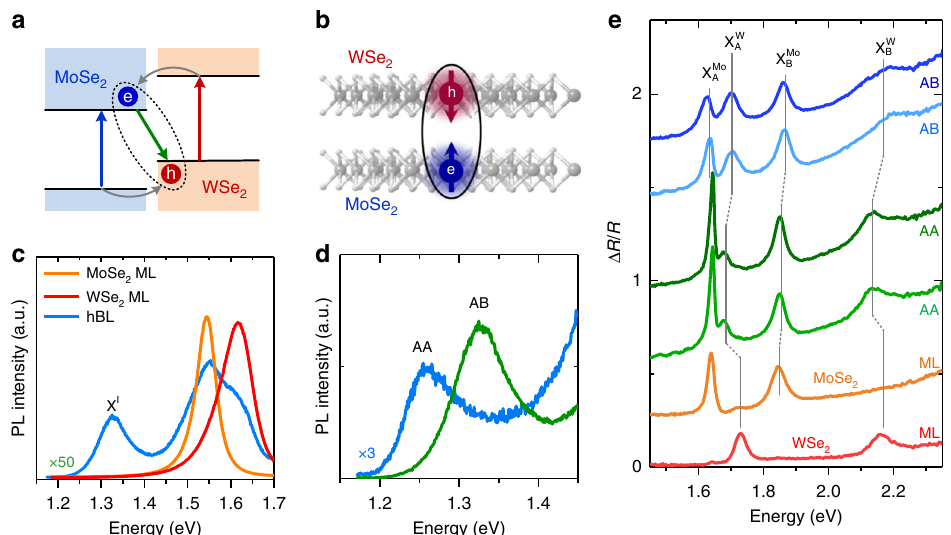
Fig. 2 Interlayer excitons in WSe 2 /MoSe 2 hBLs with AA and AB stacking. a The type-II band alignment of WSe 2 /MoSe 2 hBLs. b Schematics of interlayer excitons with electrons (e) and holes (h) located in the MoSe 2 and WSe 2 layers, respectively. c PL spectra for monolayer WSe 2 , MoSe 2 , and the WSe 2 / MoSe 2 hBL with AB stacking. The interlayer exciton X I is observed at 1.33 eV. d A comparison of X I peaks in hBLs with AA and AB stacking. The PL spectra shown in c and d were measured at room temperature ( T = 300 K). e Differential re fl ectance spectra Δ R / R for monolayer (ML) WSe 2 , ML MoSe 2 , and hBLs with AA and AB stacking. The Δ R / R spectra were measured at T = 4 K. X Mo For each stacking, two spectra from different hBL fl akes are displayed in order to demonstrate the consistent spectral